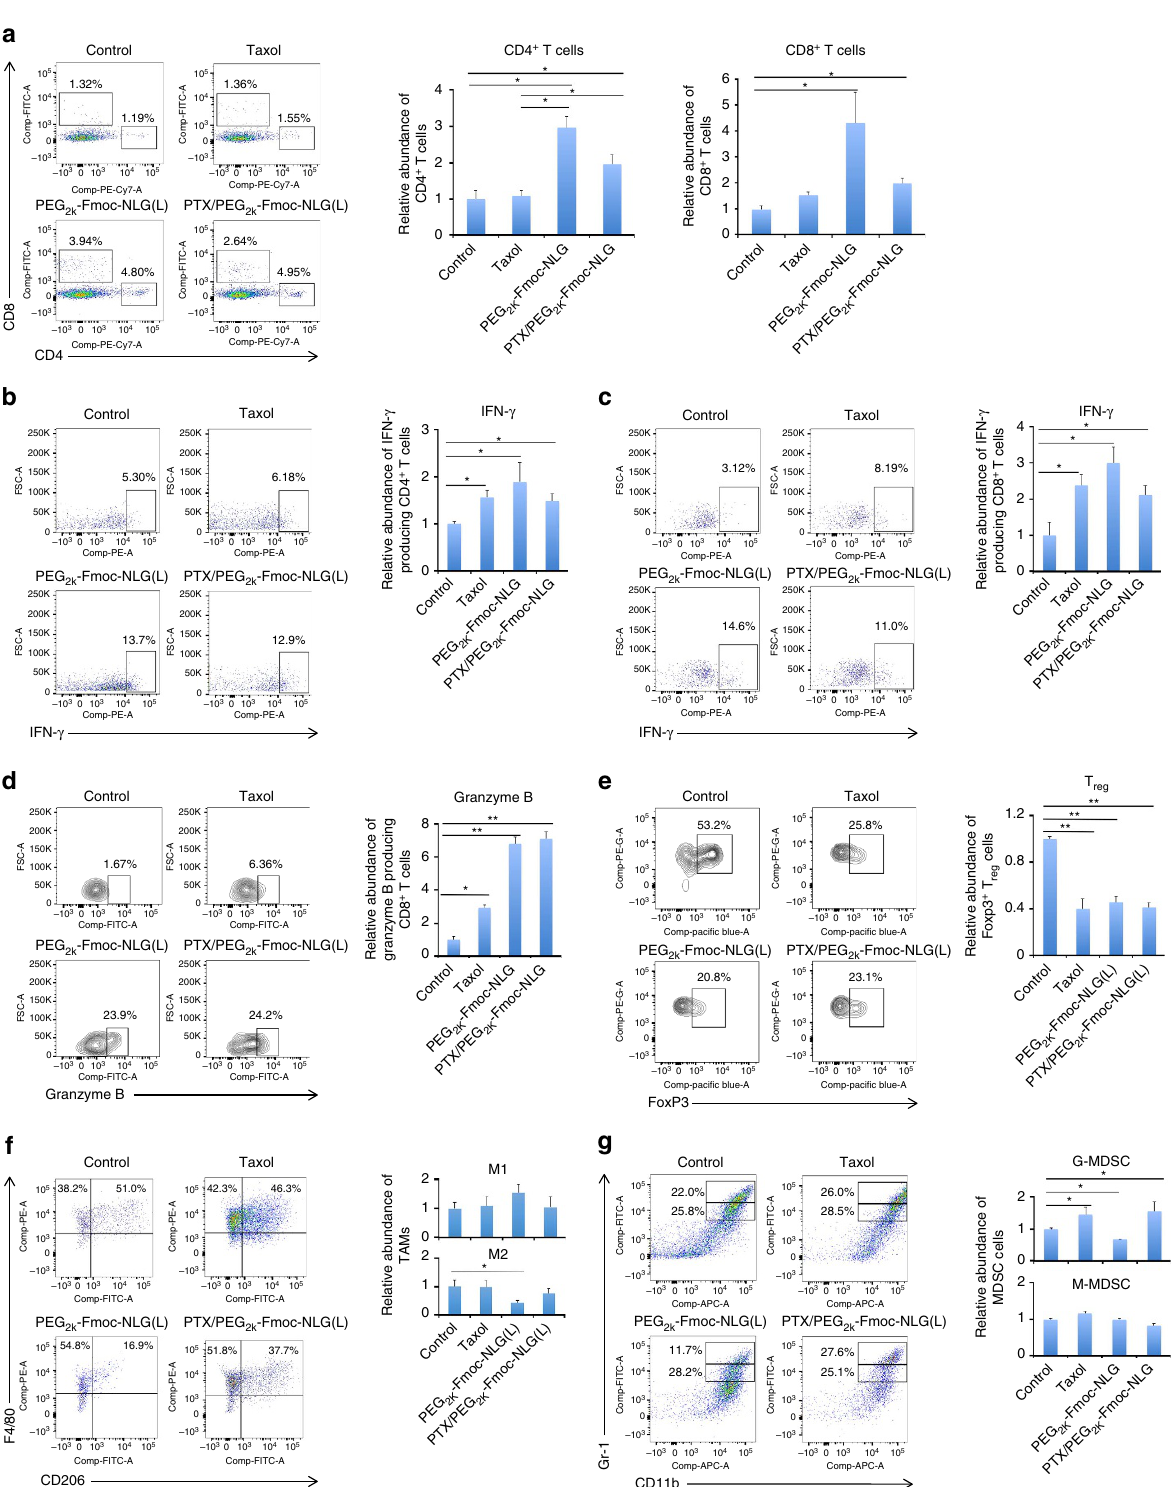
Figure 6 | Flow cytometry analysis of immune cell subsets in tumour tissues. ( a – d ) T-cell infiltration in mouse tumours treated with Taxol, PEG 2k -Fmoc- NLG(L) or PTX/PEG 2k -Fmoc-NLG(L) at a PTX dosage of 10mgkg (cid:2) 1 . The relative abundance of CD4 þ , CD8 þ ( a ), IFN- g positive intratumoural CD4 þ Tcells ( b ), IFN- g positive intratumoural CD8 þ Tcells ( c ), and granzyme B-positive CD8 þ Tcells ( d ) in tumour tissues were detected by flow cytometry. ( e ) Flow cytometry gating and histogram analysis of FoxP3 þ T regulatory cells in mouse tumours. ( f ) Tumour-associated macrophages (TAMs) in mouse tumours. The percentages of TAM populations with specific macrophage markers (M1-type (CD11b þ /F4/80 þ /CD206 (cid:2) ) and M2-type (CD11b þ /F4/80 þ / CD206 þ )) in tumour tissues were detected by flow cytometry. ( g ) Flow cytometry gating and histograms analysis of CD11b þ /Gr-1 þ MDSC cells in mouse tumours. Double positive cells contain two populations, including Gr-1 high CD11b þ granulocytic (G-MDSC) and Gr-1 int CD11b þ monocytic (M-MDSC) MDSC subsets. The bars represent means ± s.e.m. (* P o 0.05, ** P o 0.01, N ¼ 3).